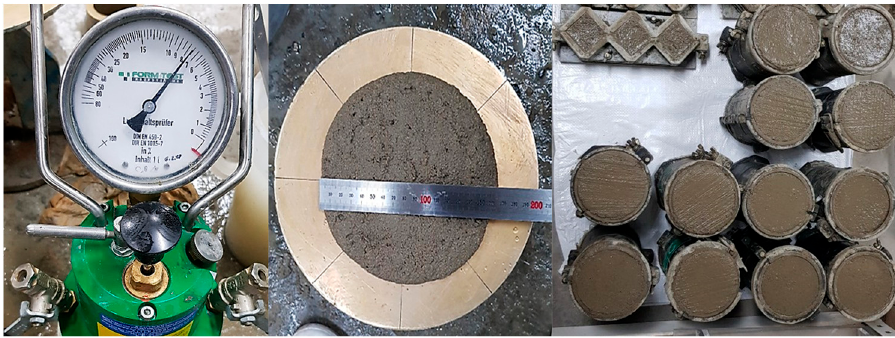
Figure 2. Measurement of air content, flow, and compressive strength specimens.